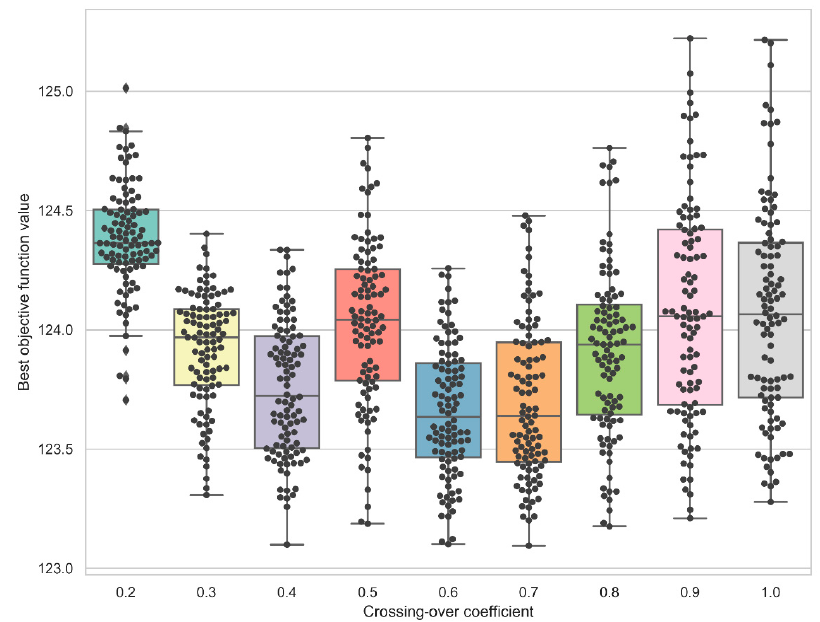
Figure 6. Boxplot diagrams of the resultant objective function values 𝜑(𝑥̅) for a number of crossing-over coefficients ( 𝑠 = 𝑐𝑜𝑛𝑠𝑡, 𝐹 = 𝑣𝑎𝑟) .